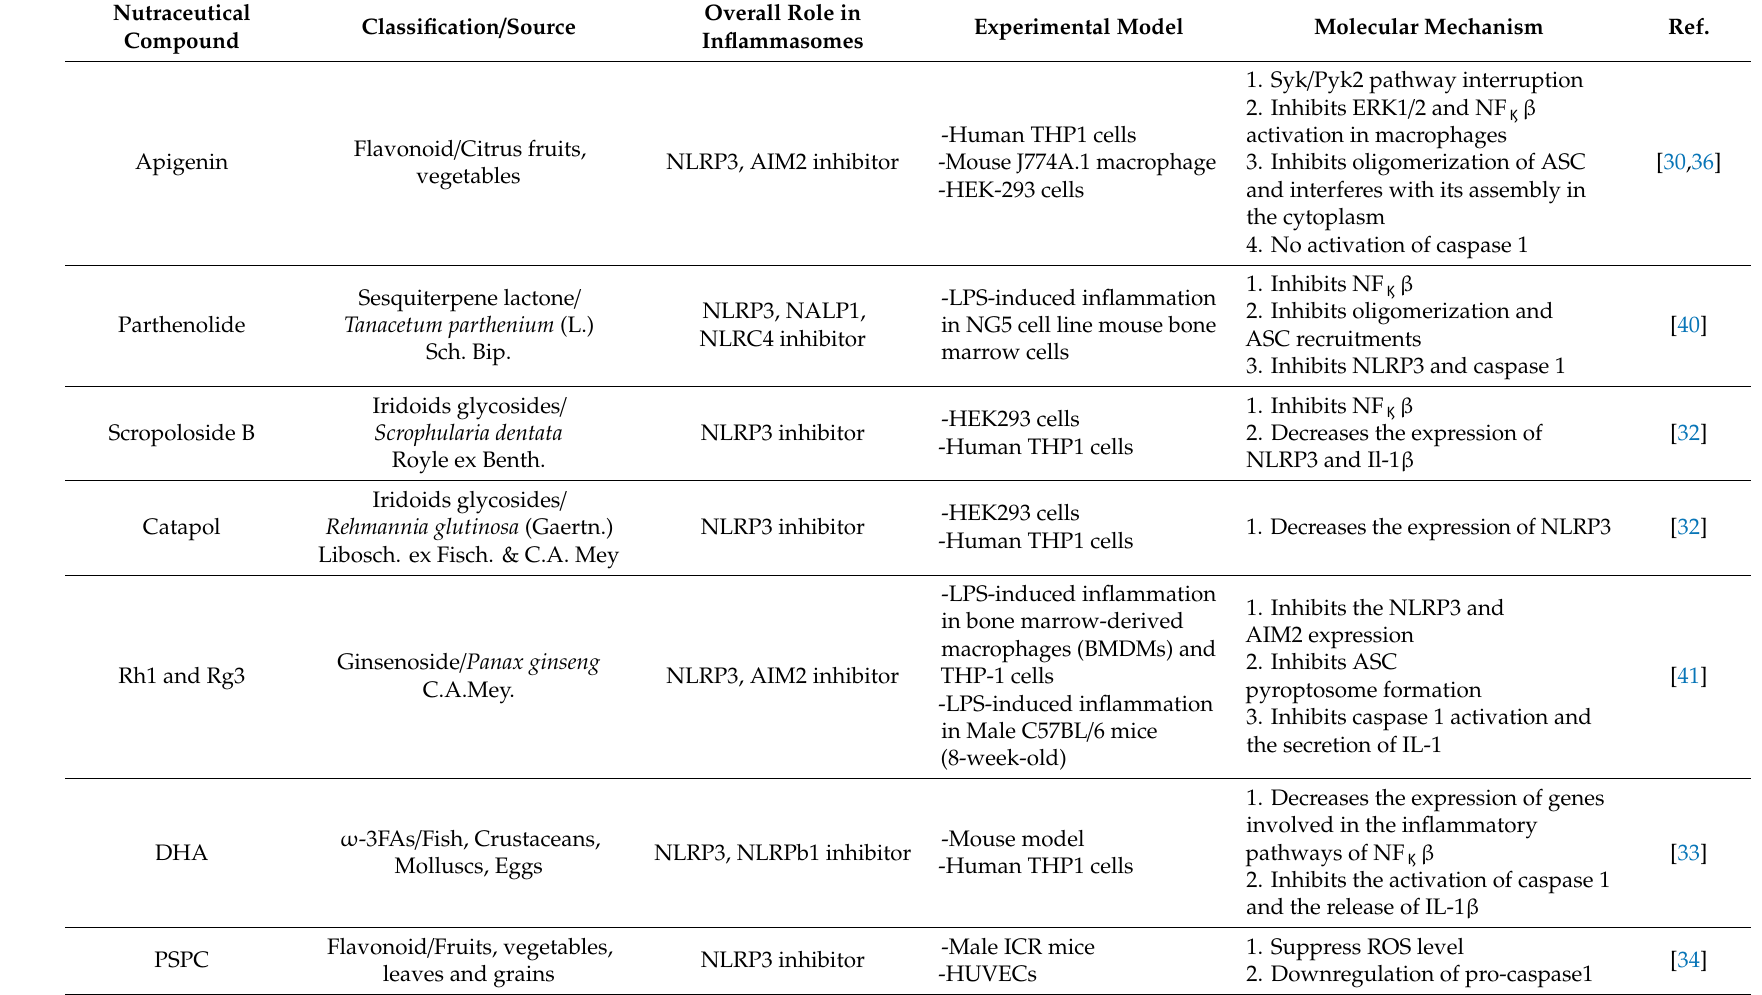
Table 1. List of Nutraceutical Compounds targeting Inflammasomes in Cardiovascular